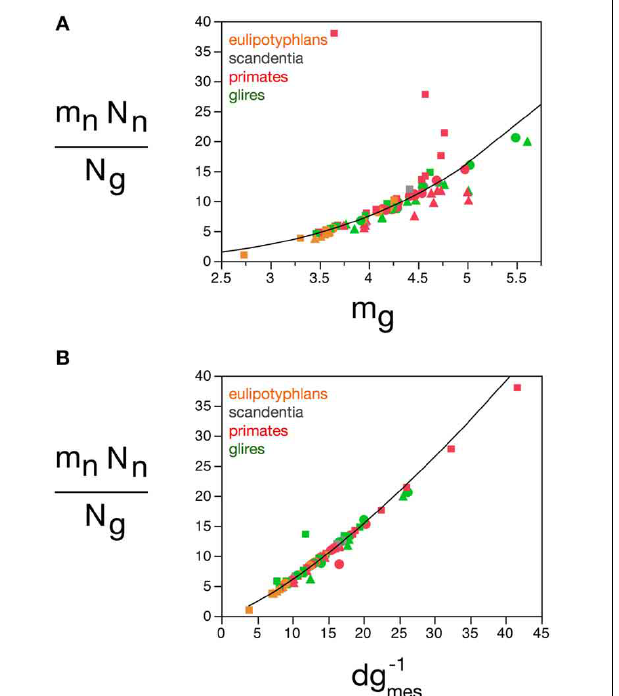
FIGURE 14 | Neuronal mass per glial cell varies with average glial cell mass across brain structures and species. Graphs show the average neuronal mass per glial cell ( m n N n / N g ) as (A) a function of estimated glial cell mass ( m g ) and (B) a function of the inverse of measured glial cell density ( d − 1 gmes ) in each brain structure in each species. Average glial cell mass in picograms; d − 1 gmes in picograms/neuron. Functions plotted are (a) N n . m n / N g = 0.064 m g 3 . 433 ± 0 . 260 ( r 2 = 0 . 691, p < 0 . 0001) and (B) m n .N n / N g = 0.275 d − 1 gmes 1 . 343 ± 0 . 033 ( r 2 = 0 . 954, p < 0 . 0001). Cerebral cortex plotted as circles, cerebellum as squares, and rest of brain as triangles; eulipotyphlans shown in orange, primates in red, and rodents in green. Data from Herculano-Houzel et al. (2006, 2007, 2011), Azevedo et al. (2009), Sarko et al. (2009), and Gabi et al.